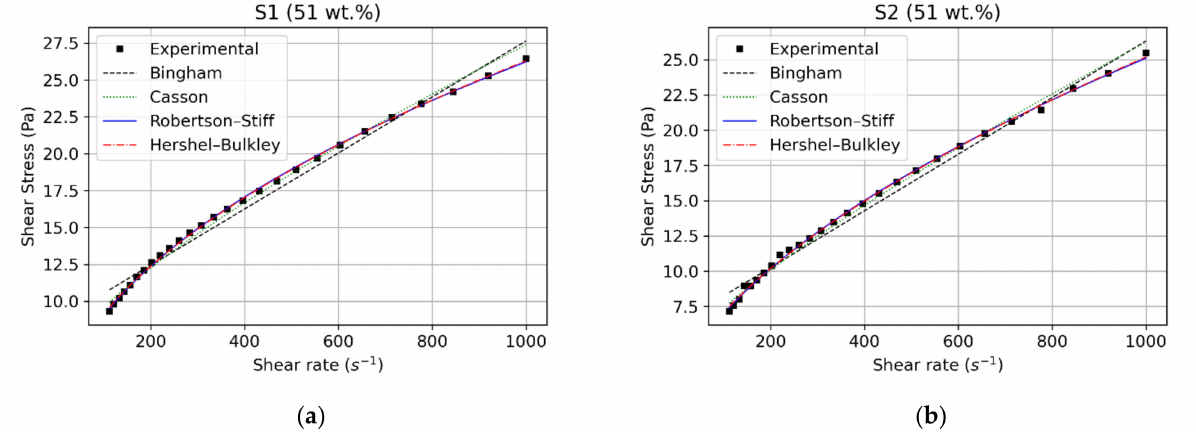
Figure 4. Comparison of rheological model fits for ( a ) S1 and ( b ) S2.